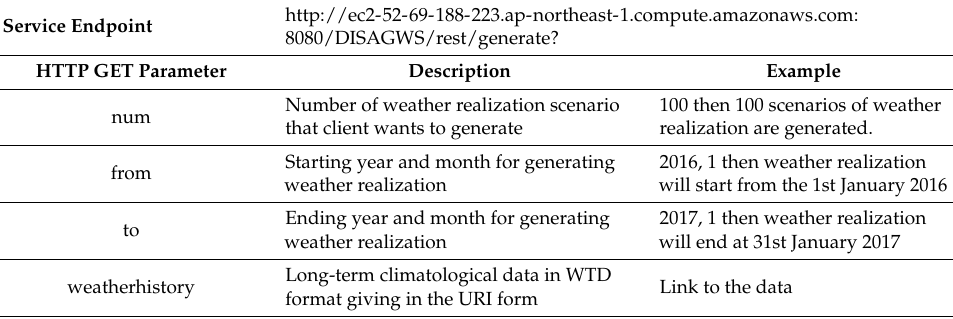
Table 3. Request parameter of the DisAg